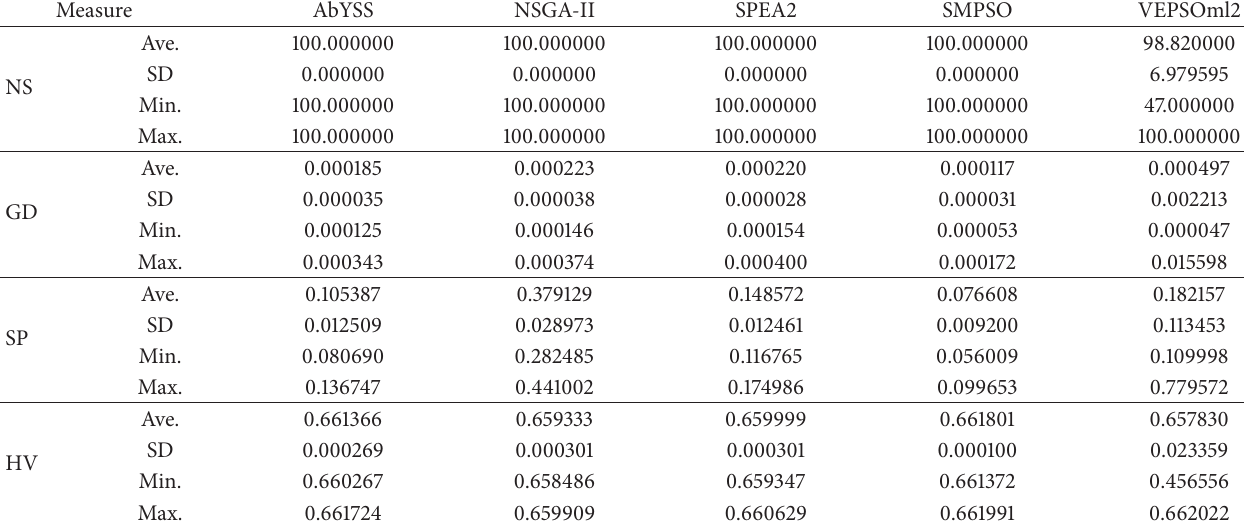
Table 7: Performance comparison based on ZDT1 test problem.